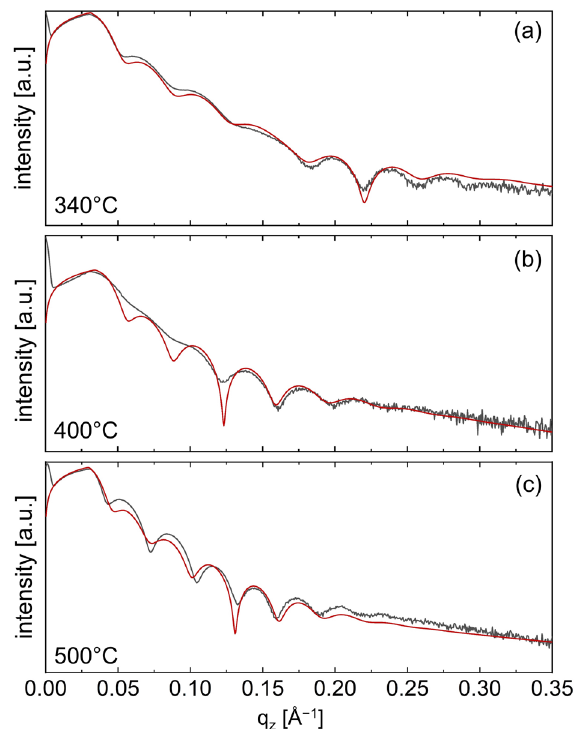
Figure 2. X-ray reflectivity measurements of ZnO thin films with ( a ) 14.5%, ( b ) 16%, and ( c ) 24% of open porosity. Red lines correspond to the employed fits.